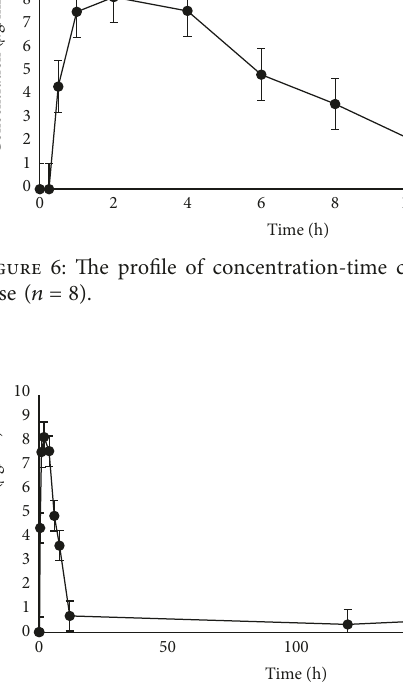
Figure 7: The profile of concentration-time curve after a multiple dose ( n (cid:31)